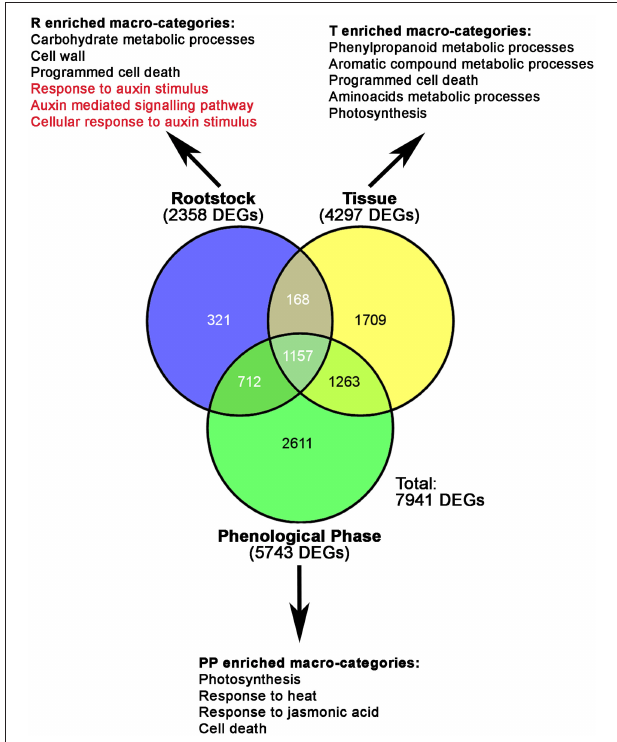
FIGURE 3 | Venn diagrams showing the relative numbers of specific and common DEGs resulting from the multifactorial analyses, according to an FDR corrected p -value lower than 0.05. Numbers of DEGs influenced by each component (R, Rootstock; T, Tissue; PP, Phenological Phase) are given in brackets. The most significant categories resulted from GO enrichment analysis carried out on DEGs influenced by R, T, and P, are also